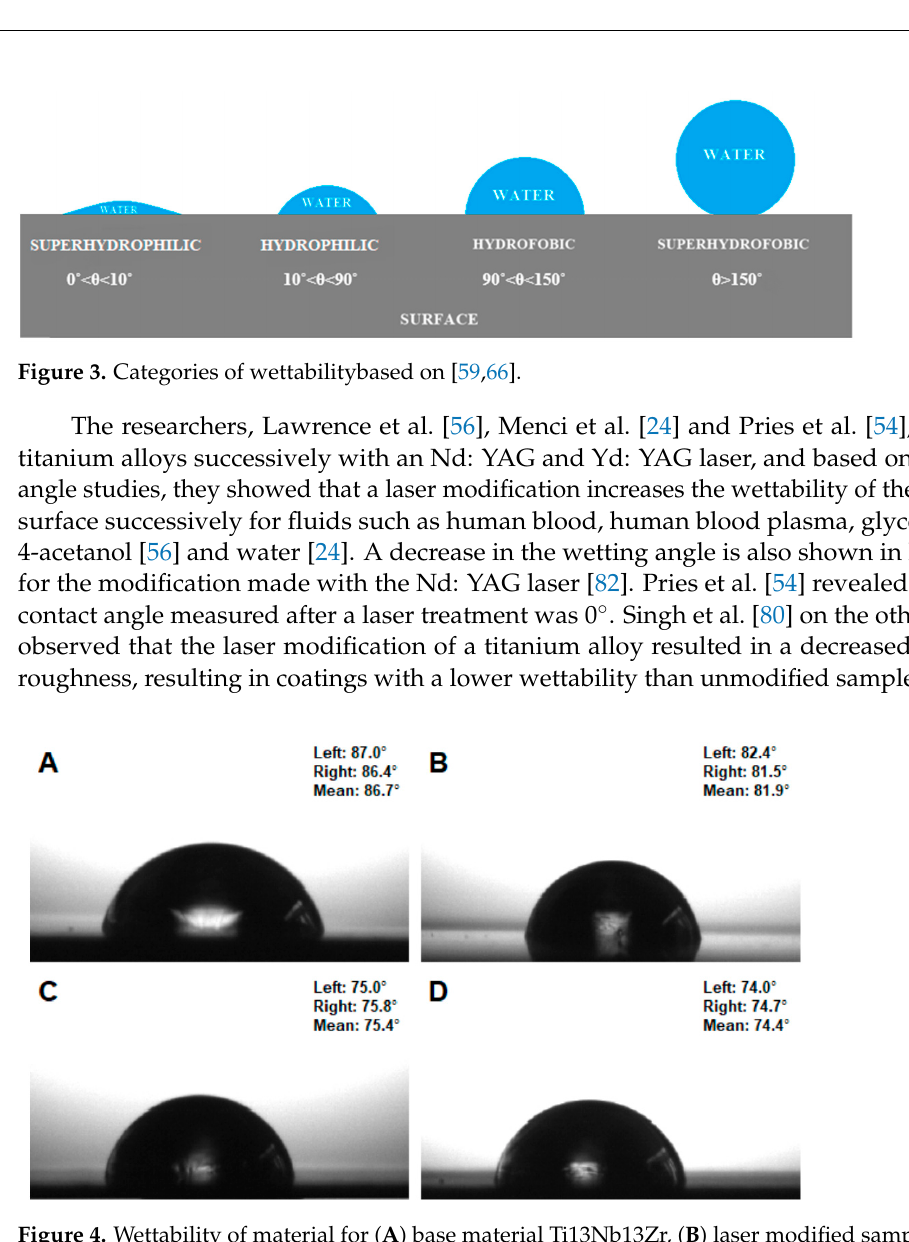
Figure 4. Wettability of material for ( A ) base material Ti13Nb13Zr, ( B ) laser modified sample 700 W, ( C ) laser modified sample 1000 W, and ( D ) laser modified sample 700 + 1000 W [82].